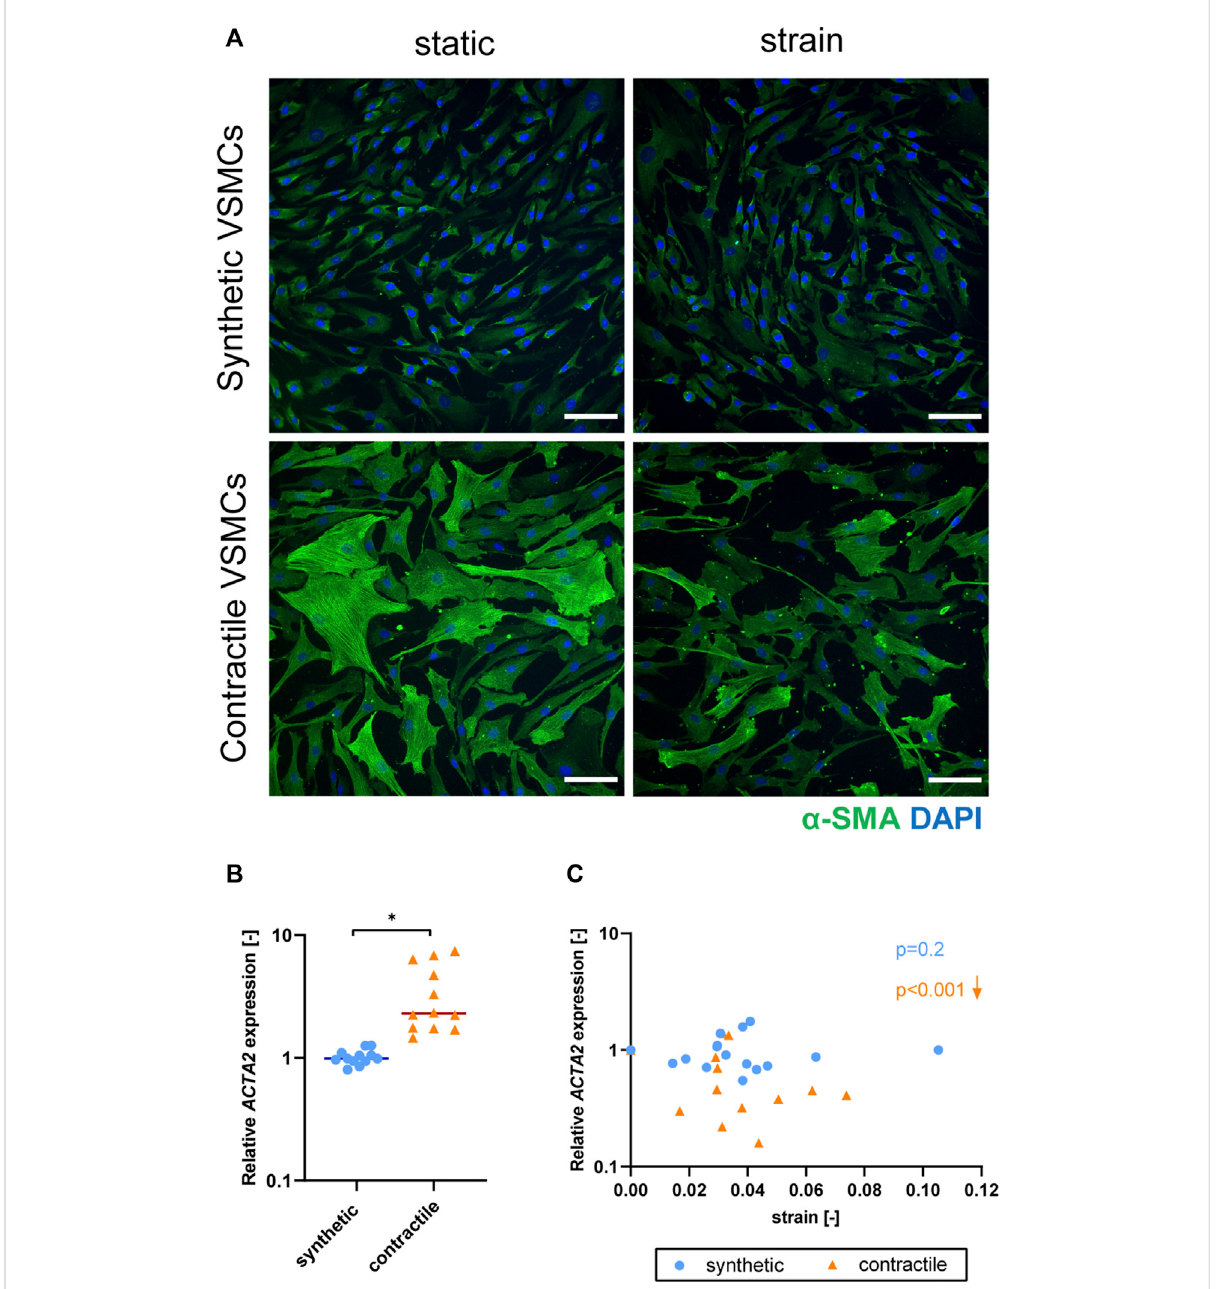
FIGURE 5 The effect of strain on VSMC phenotype. (A) Representative IF images of α SMA (green) and nuclei (blue) in synthetic and contractile VSMCs, in the absence of strain (static) and upon the application of 0.04 (4%) strain for 48 h (scale bar: 100 μ m). Gene expression of phenotype marker ACTA2 for synthetic (blue circles) and contractile (orange triangles) VSMCs (B) in the absence of strain (normalized to the synthetic control) and (C) as a function of strain (each data point is normalized to its corresponding static control expression). p values show the signi fi cance level of non- parametric Spearman correlation coef fi cient. The arrows next to signi fi cant correlations ( p < 0.05 ) demonstrate an up or downregulation in gene expression with applied strain